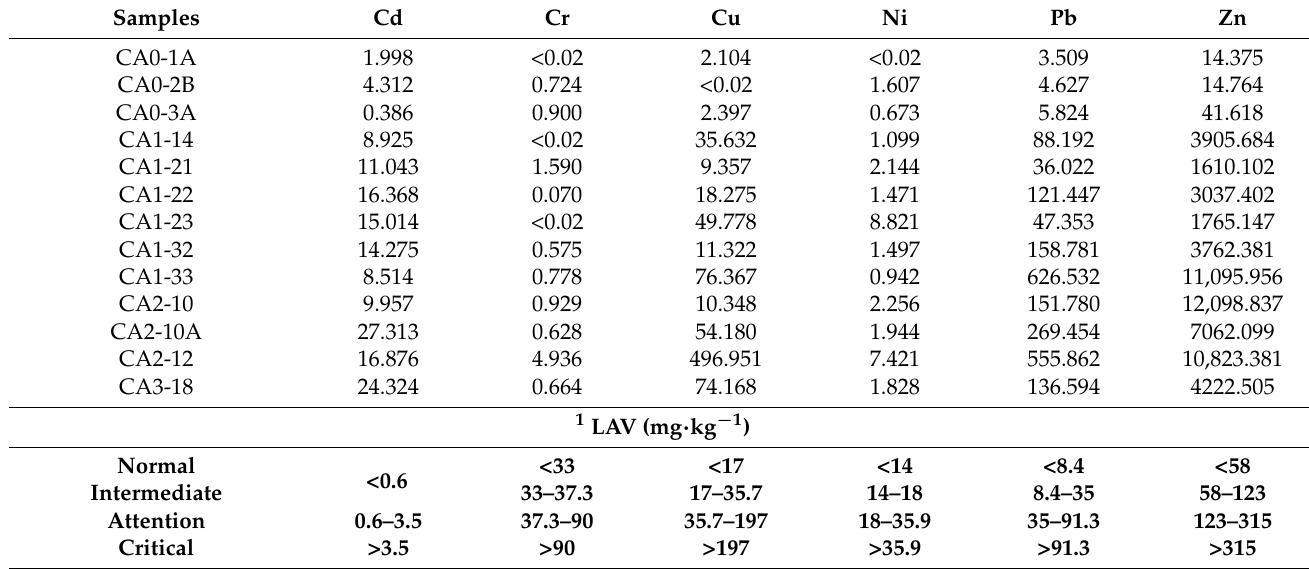
Table 4. Average values (mg · L − 1 ) obtained in the ammonium acetate extraction test for the most relevant